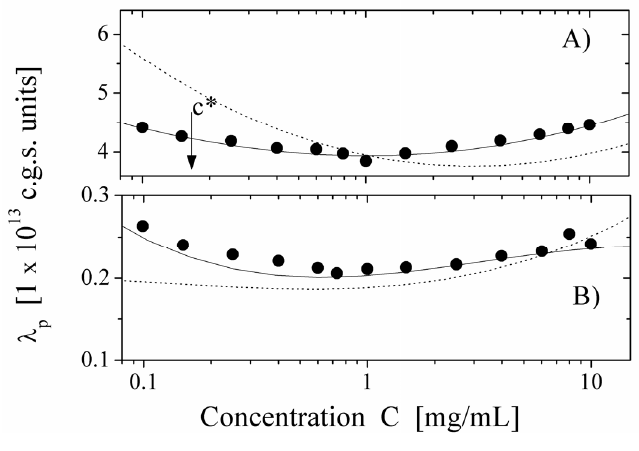
Figure 9. The equivalent conductance of 17% PMVP-Cl ( Q = 17%) polyion as a function of concentration C . Panel ( A ) polyion in water solution (poor-solvent